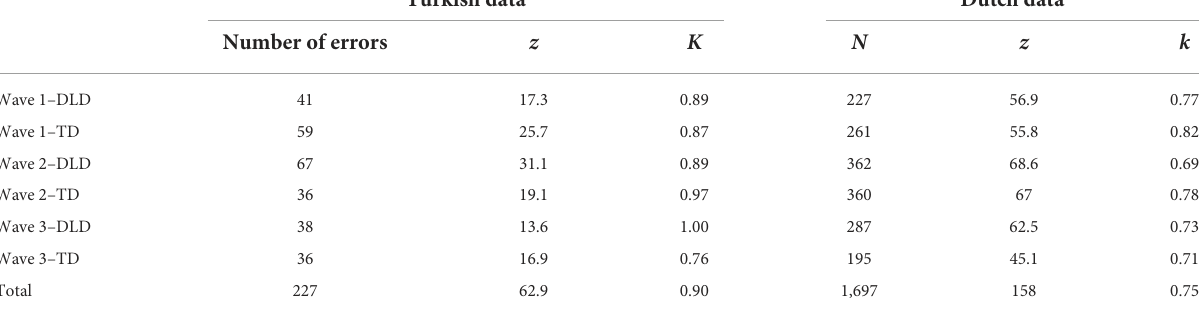
TABLE 2 Inter-rater reliability for Dutch and Turkish data.